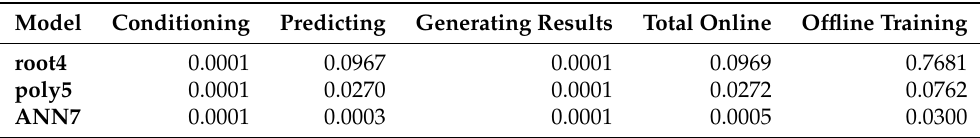
Table 5. Computational time benchmark results (in seconds).